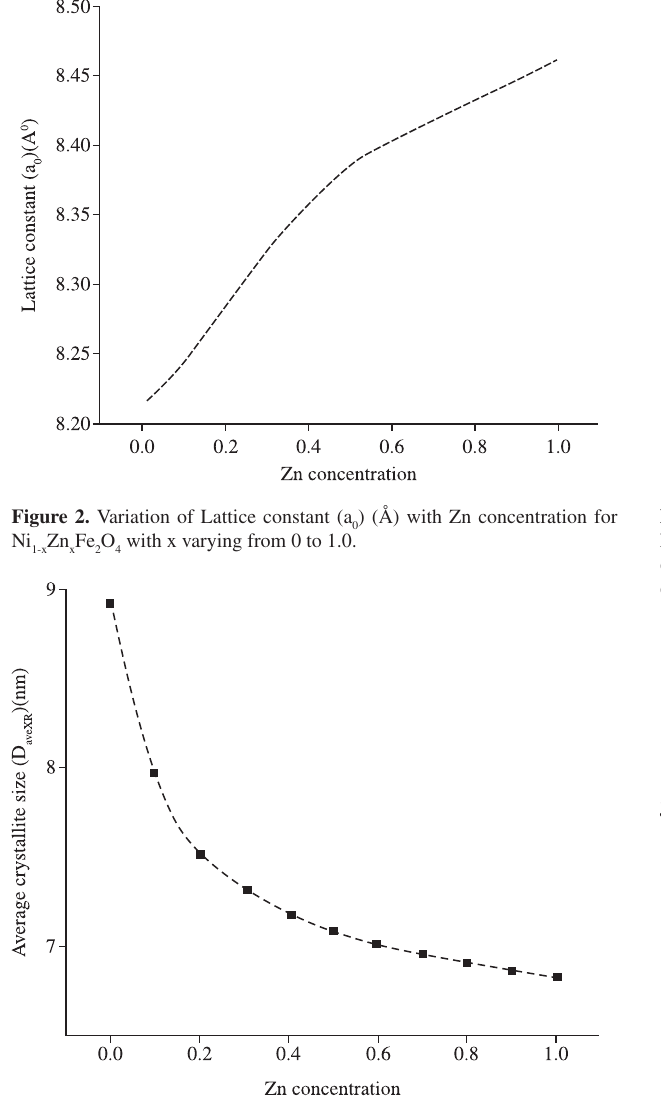
Figure. 3. Variation of the average crystallize size with Zn concentration for Ni Zn Fe O with x varying from 0 to 1.0. 1-x x 2 4